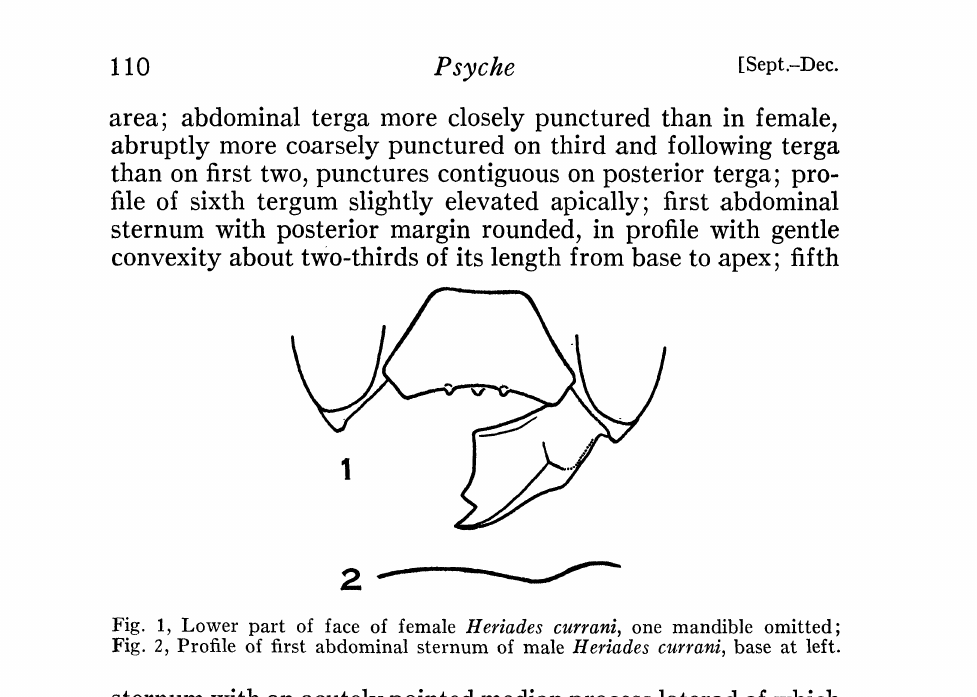
Fig. 1, Lower part of face of female Heriades currani, one mandib|e omitted; Fig. 2, Profile of first abdominal sternum of male Heriades currani, base at left. sternum with an .acutely pointed median process laterad of which lie the usual rows of long capitate hairs; sixth sternum but little extending beyond margin of